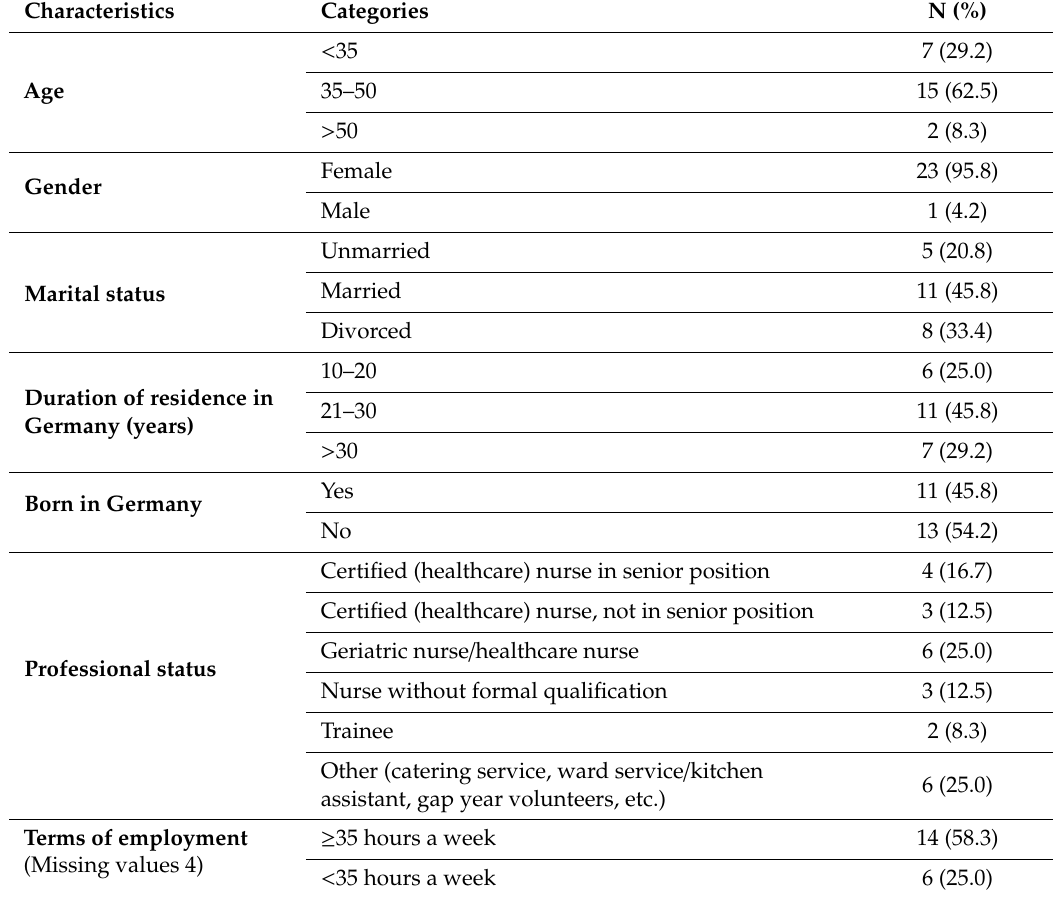
Table 1. Characteristics of the sample (N =